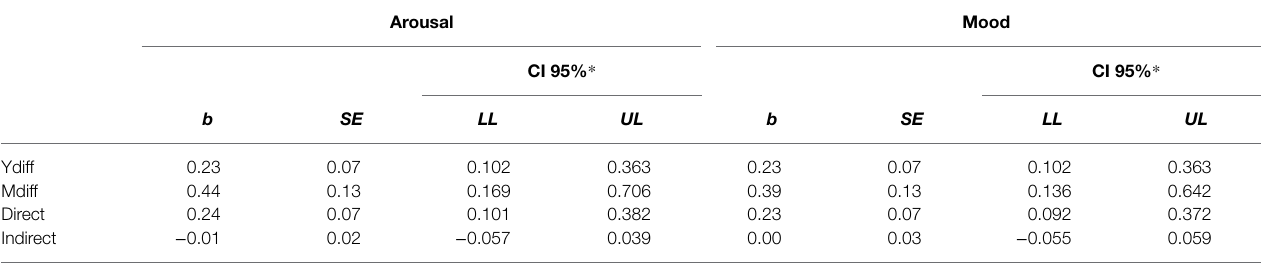
TABLE 2 | Effect coefficients of the analysis testing arousal and mood as mediators of originality of ideas. Arousal